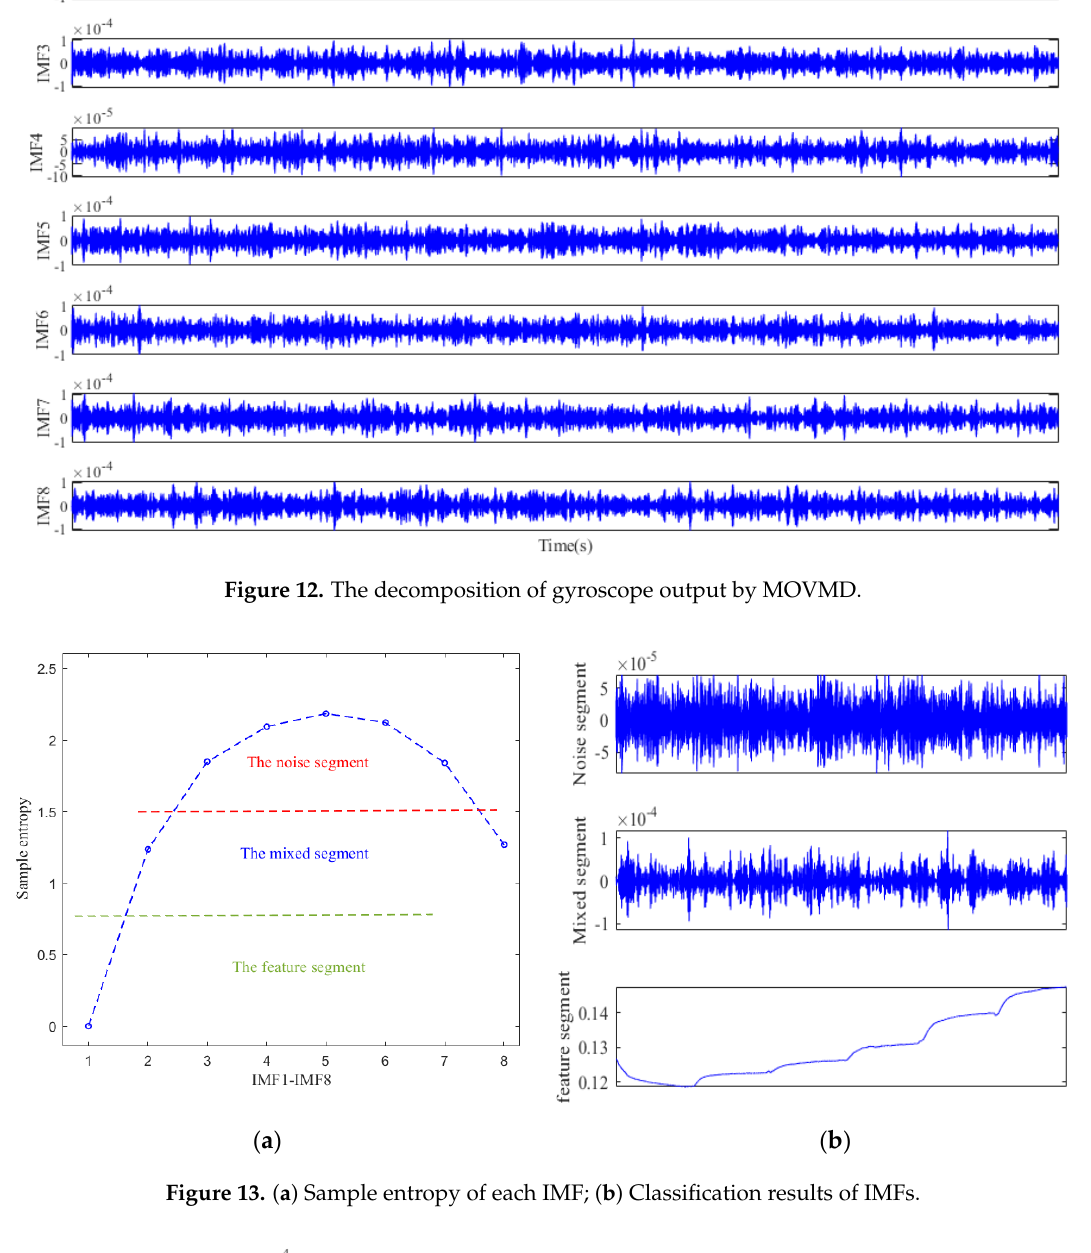
Figure 13. ( a ) Sample entropy of each IMF; ( b ) Classification results of IMFs.